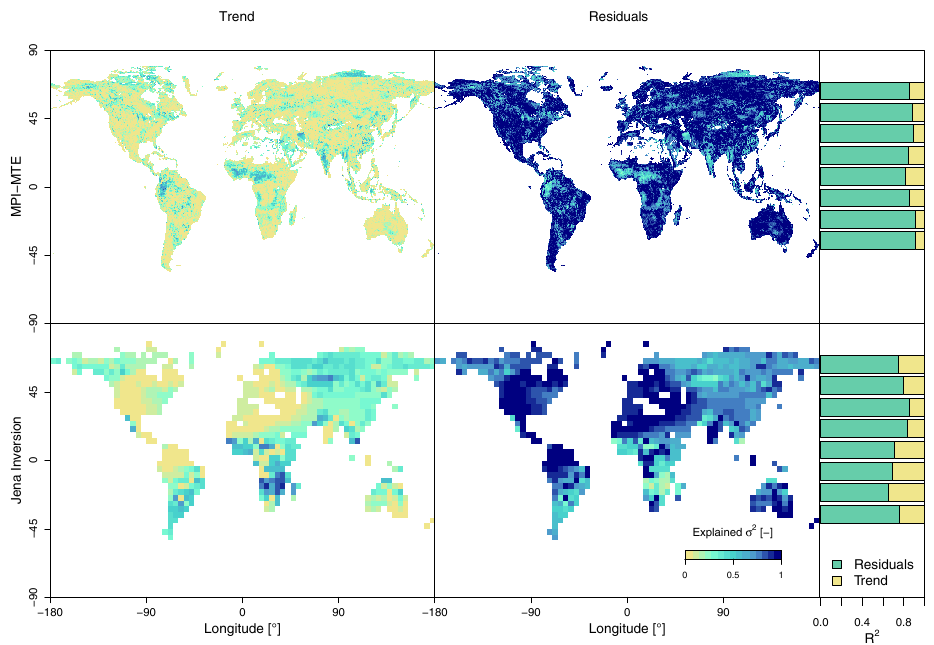
Figure 5. Maps of the fraction of NEE variance explained by temporal trends and anomalies for MPI-MTE NEE and the Jena Inversion; latitudinal band (15 ◦ ) averages of the fractions are shown in the bar plots.